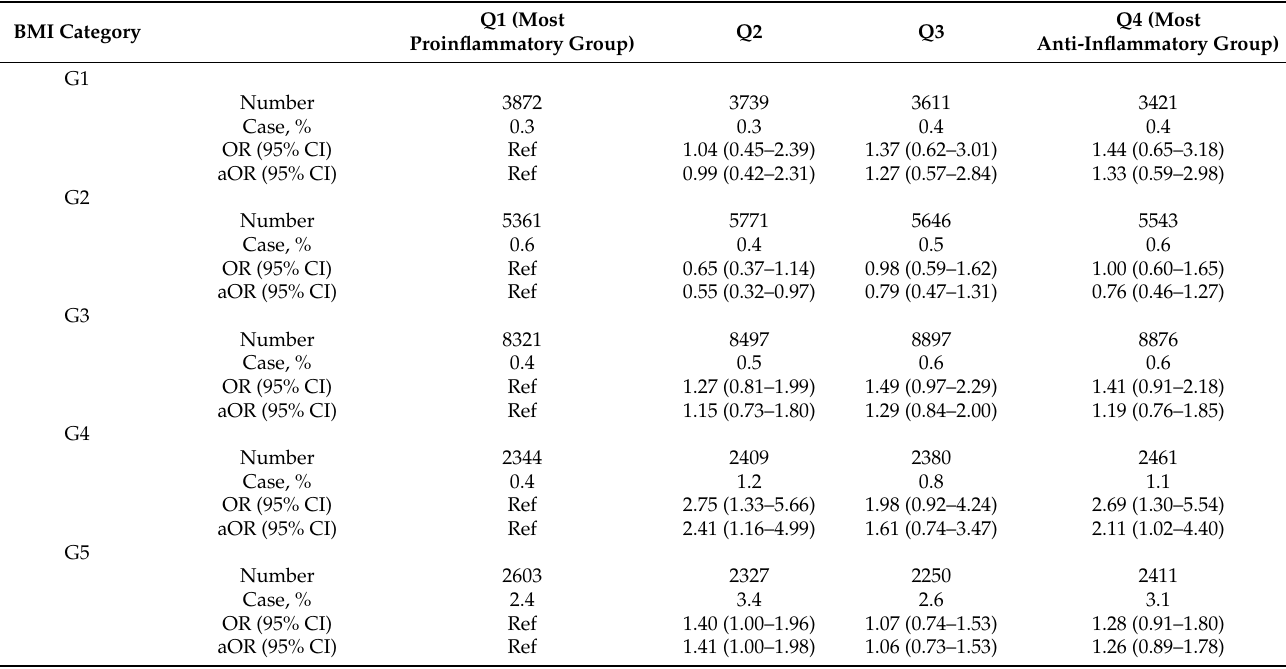
Table 4. Relationship between the dietary inflammatory index and the risk of early diagnosed gestational diabetes mellitus